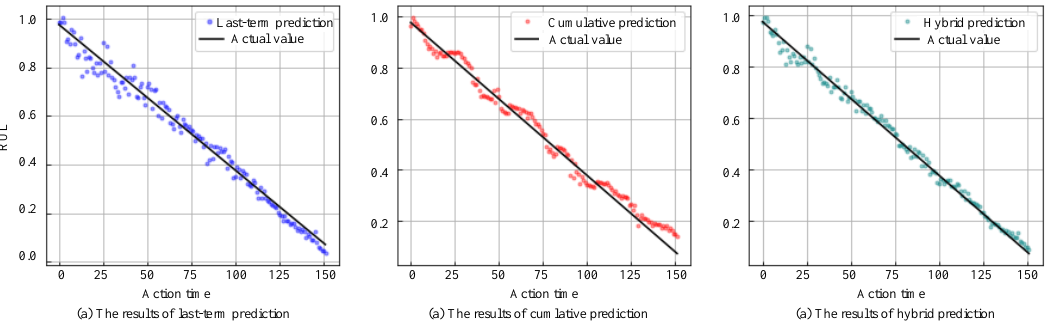
Figure 10. The results of latest stage degradation prediction, long-term cumulative degradation prediction and hybrid prediction for number 148 in FD002. ( a ) The comparison between latest stage cumulative degradation prediction and actual values. ( b ) The comparison between long-term degradation prediction and actual value. ( c ) The comparison between hybrid prediction and actual